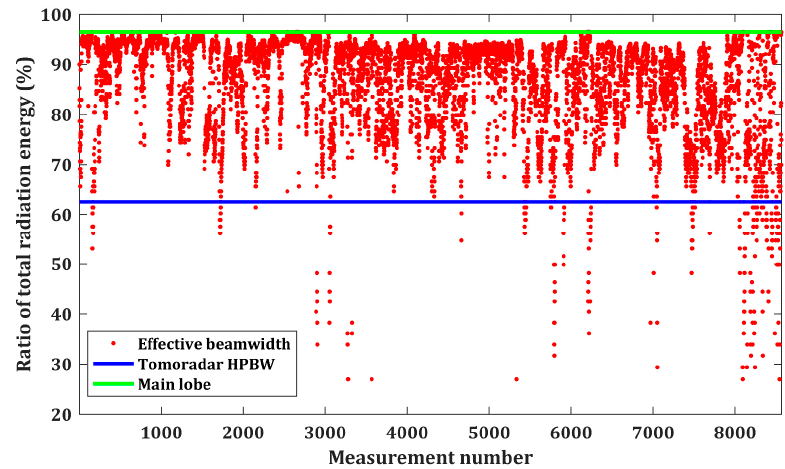
Figure 13. The ratios of radiation energy within the effective beamwidths, main lobe and Tomoradar half-power beamwidth (HPBW), to total radiation energy. The ratio of total radiation energy within Tomoradar HPBW and main lobe are 62.4% and 96.4%, respectively.